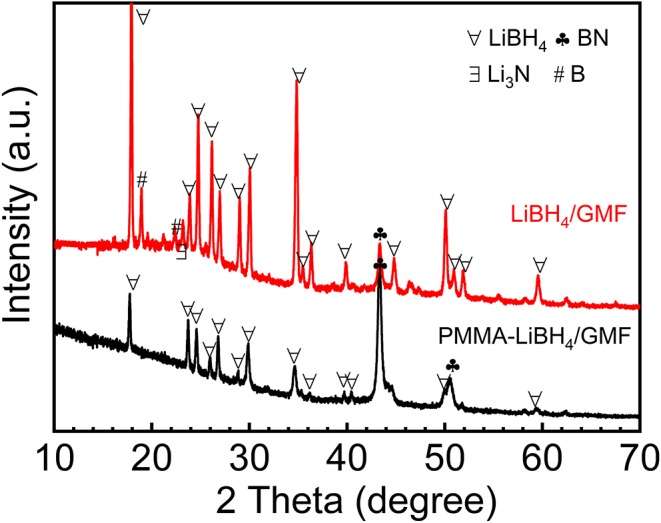
XRD patterns of LiBH4/GMF and PMMA-LiBH4/GMF.